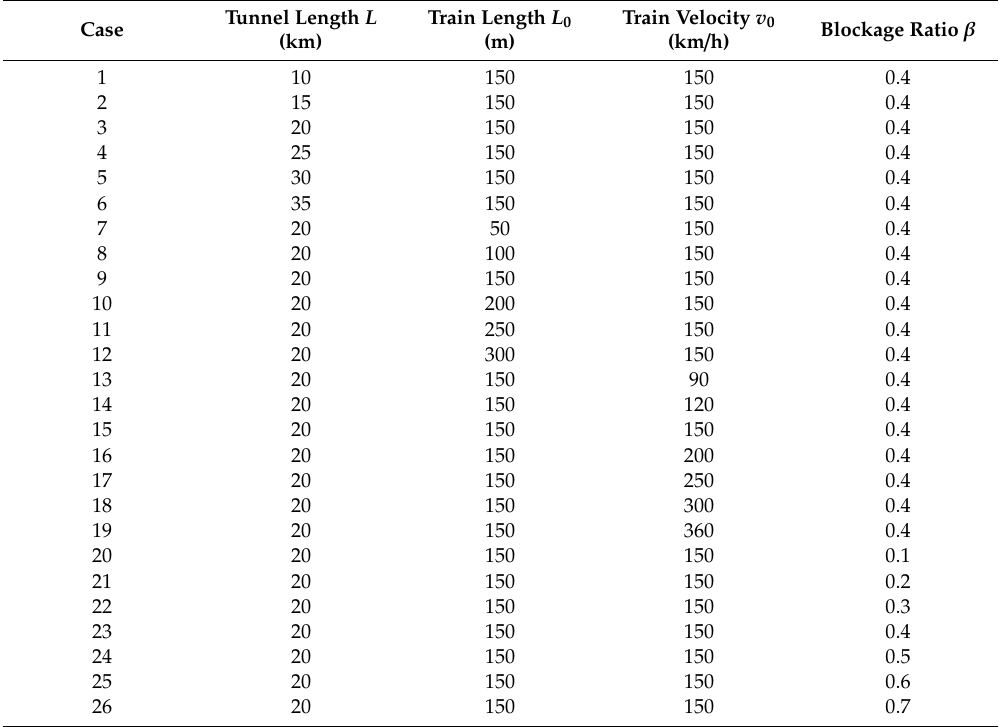
Table 4. E ff ect parameter values for calculating piston wind.